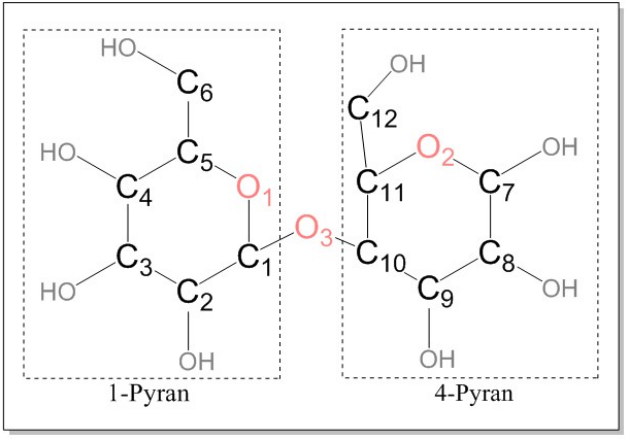
Figure 2. Major labeled atoms of cellobiose.